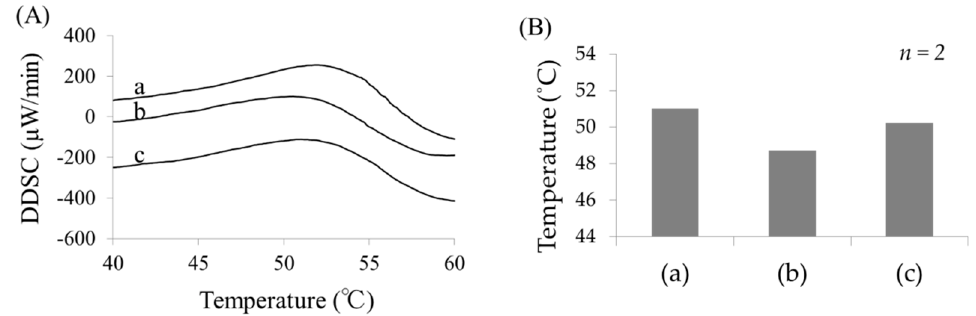
Figure 13. ( A ) DDSC curves and ( B ) glass transition temperature of each hair. (a) Without treatment, (b) treated with succinic acid, (c) treated with malic acid [18]. DDSC = derivative differential scanning calorimetry